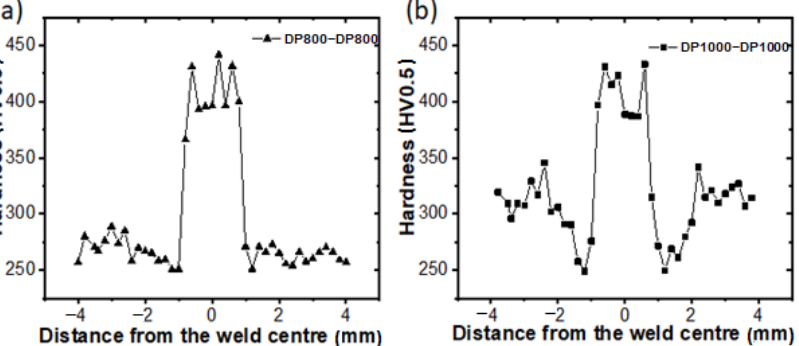
Figure 4. Microhardness profile of the laser-welded ( a ) DP800-welded joint and ( b ) D1000-welded joint.